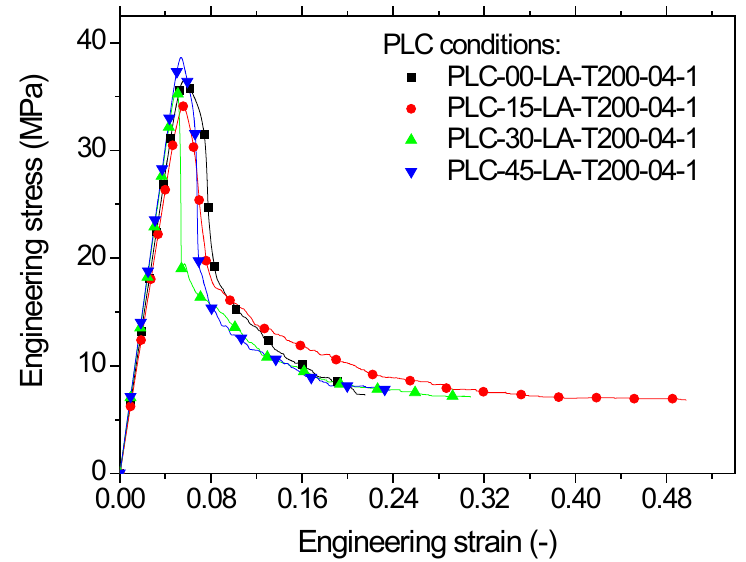
Figure 16. Tensile response of PLC printed using lateral orientation (LA) for various printing angles, i.e., ranging from 0 up to 45°.